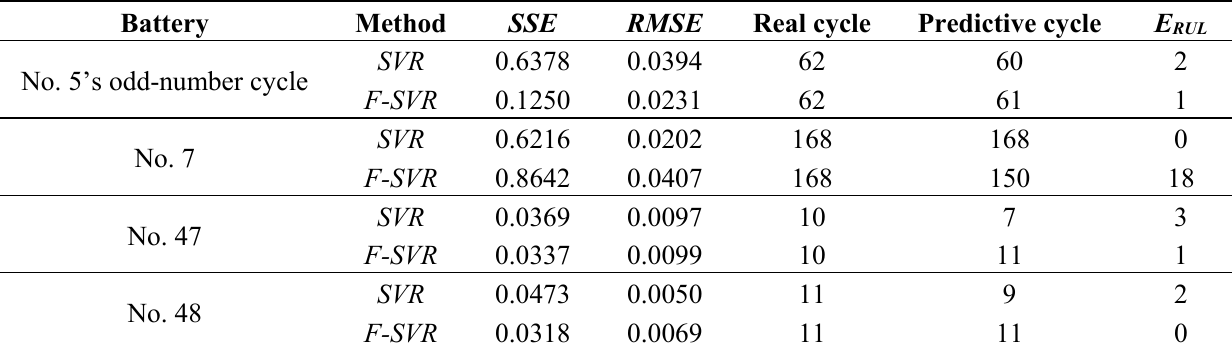
Table 2. Comparisons between the results obtained from the SVR and F-SVR methods for predicting the RUL s of different